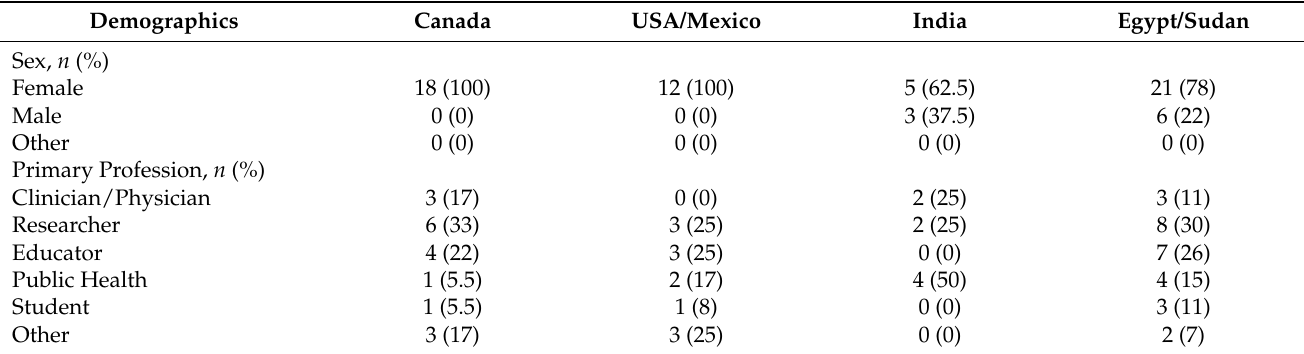
Table 1. The demographic characteristics of the focus group